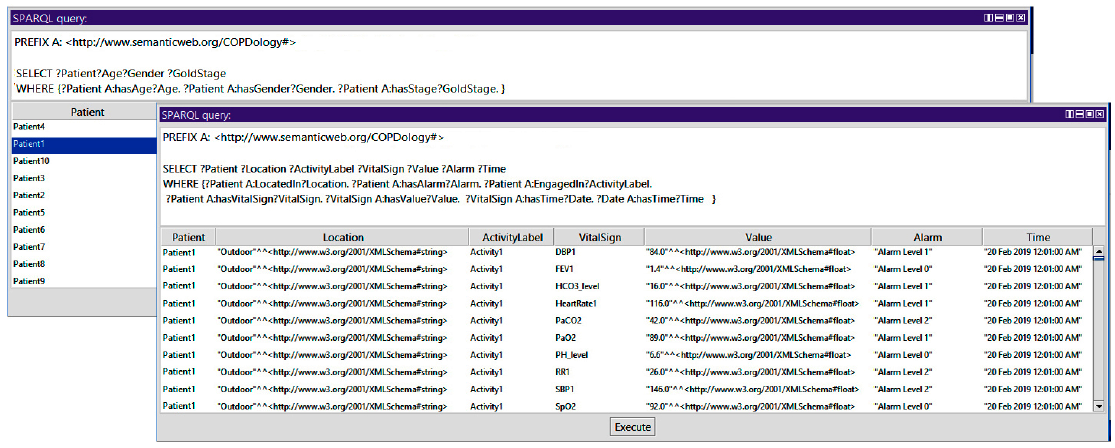
Figure 17. Query 1 and result.